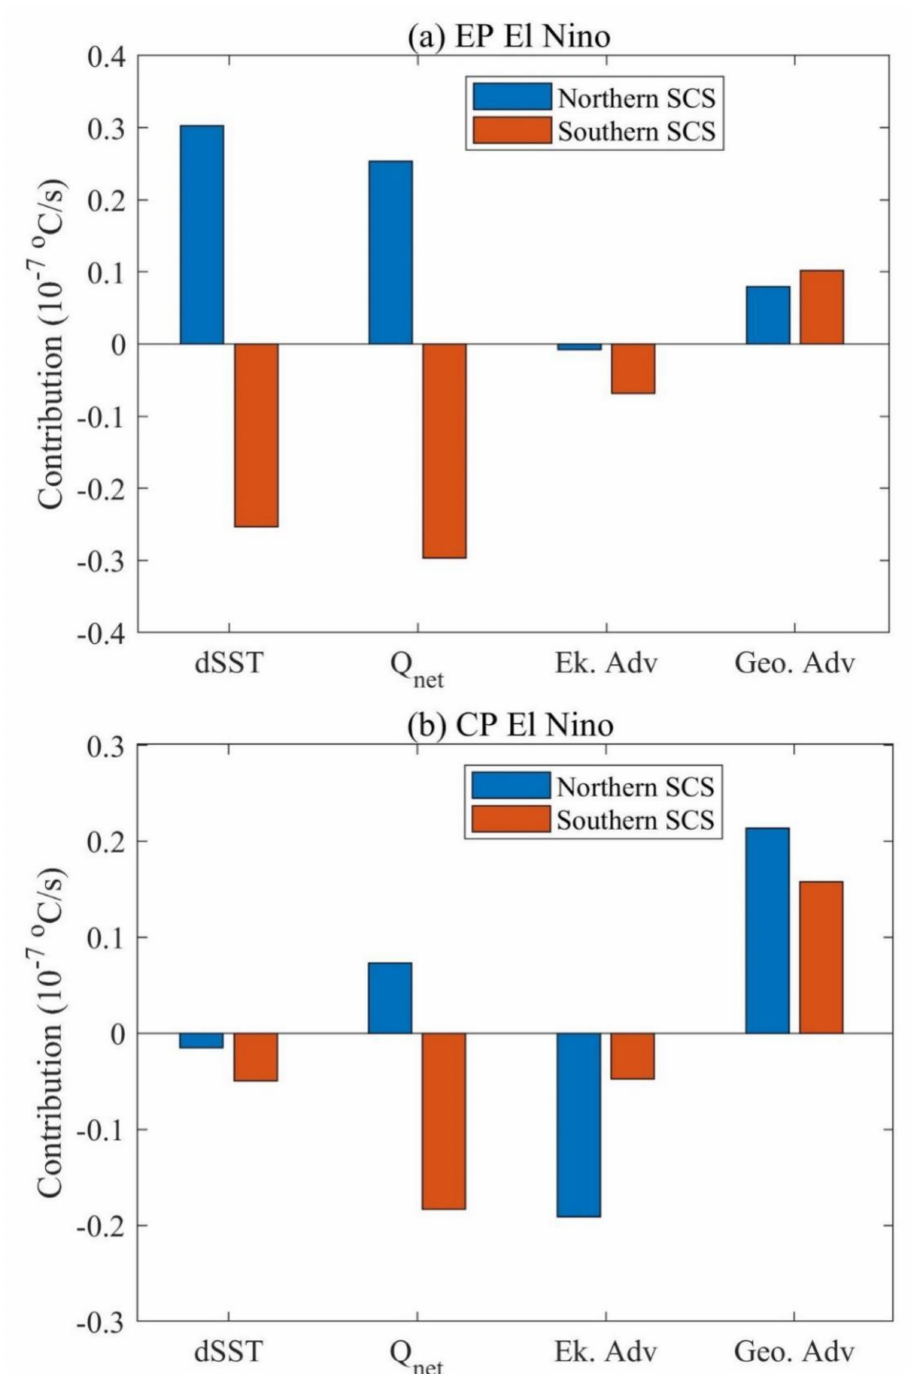
Figure 5. The tendency of SST anomalies, net surface heat flux anomalies, Ekman heat advection and geostrophic heat advection averaged in the northern and southern SCS during the spring of ( a ) EP El Niño and ( b ) CP El Niño decaying